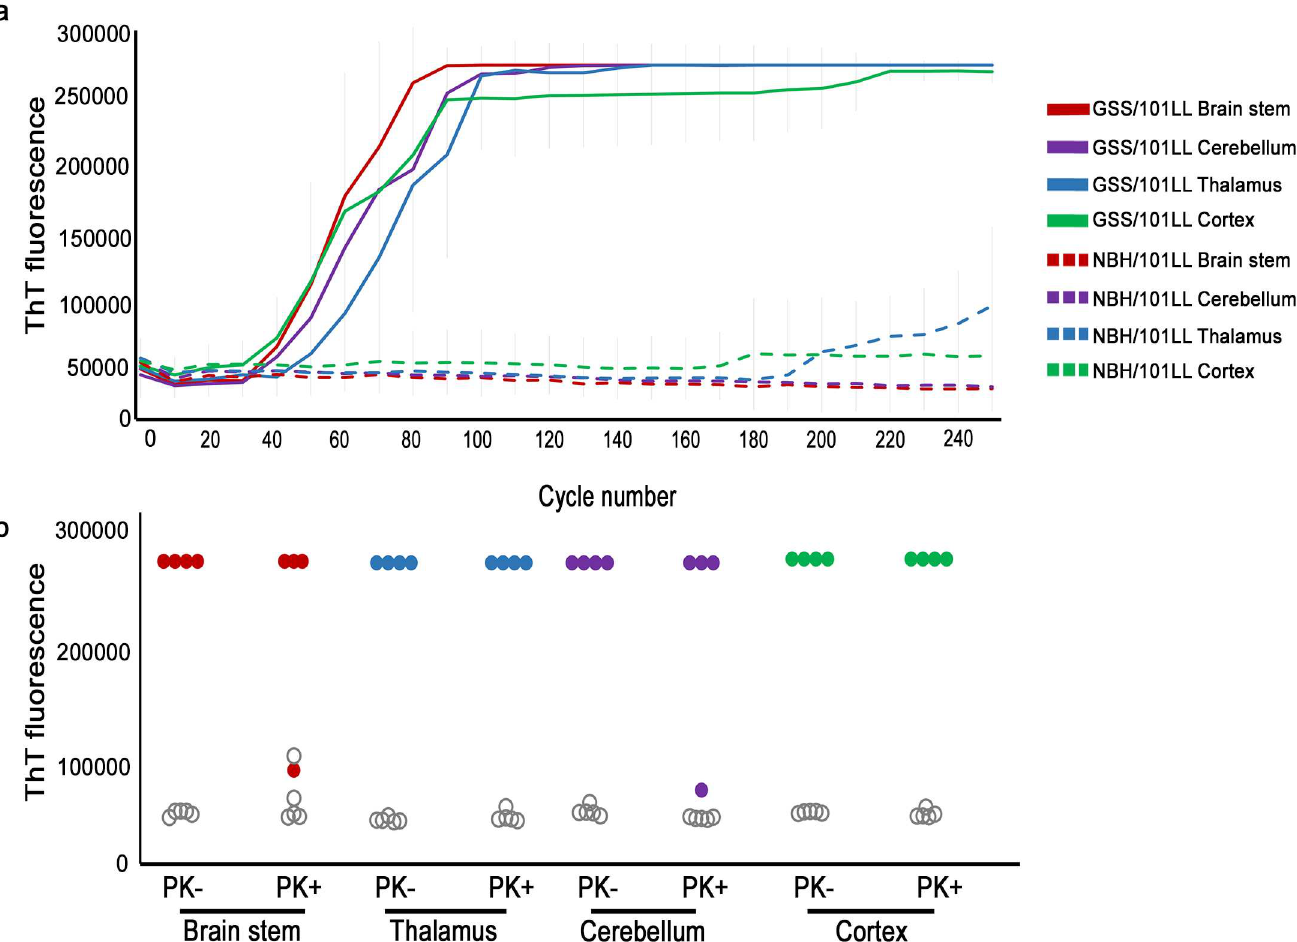
Fig 2. RT-QuIC shows widespread detection of misfolded prion seeds beyond levels detected using IHC. (a) ThT fluorescence readoutover time duringthe RT-QuIC assay. Each solid line representsa GSS/101LL brain region, whereaseach dotted line represents a NBH/101LL brain region. These data are comprisedof the averages from triplicate RT-QuIC reactions from three separate repeat experiments collectedfrom four separate GSS/ 101LLdissected brains and five NBH/101LLdissected brainsall at the terminal stage of disease(291.1 ± 5.3 dpi). The different brain regions are colour codedto illustrate the brain stem (red), thalamus(blue), cerebellum(purple), and cortex (green)for both the GSS/101LL and NBH/101LL samples. (b) RT-QuIC ThT fluorescence readout at 48 h (respectiveto cycle 190 in the RT-QuIC assay) using samples with or without PK exposure. ThT fluorescence increasesare observedin each PK-exposedbrain regionof GSS/101LL mice ( n = 4), showingthat the misfoldedPrP responsible for the seedingevent has obtaineda PK-resistant conformation in all GSS/101LL brain regions. No increase in ThT fluorescence was observedin NBH/101LL control brain regions ( n = 5), demonstrating the specificity of prion seedingability in GSS/101LL brain regions. GSS/101LL samples are presented as red (brain stem), blue (thalamus), purple(cerebellum), or green (cortex), and region-matched NBH/101LLcontrols are plotted in the same columns as grey open dots. These data are comprisedof triplicate RT-QuIC reactionsfor each brain regionof each animaltested.